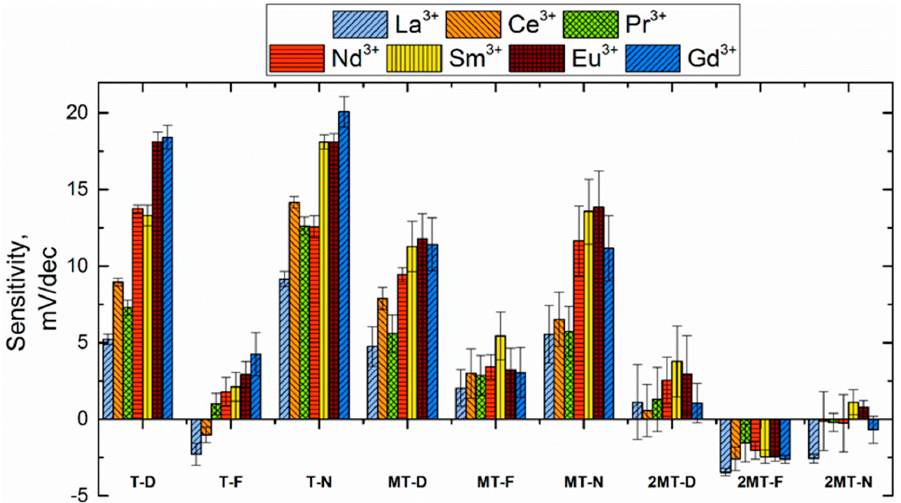
Figure 3. Sensitivity values measured in rare earth element (REE) solutions for the sensors based on TODGA and its methylated derivatives.